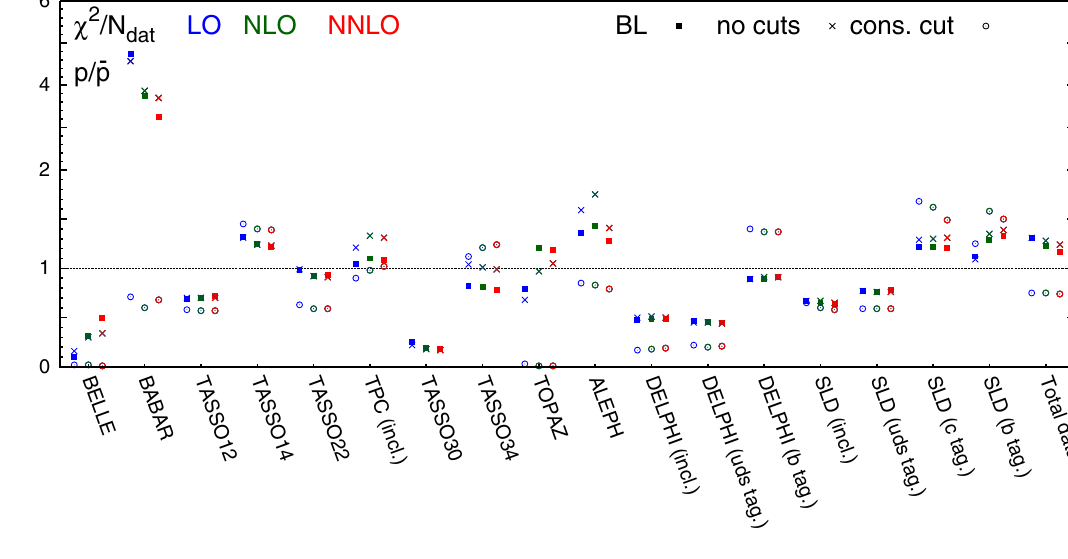
Fig. 16 Same as Fig. 14, but for p / ¯